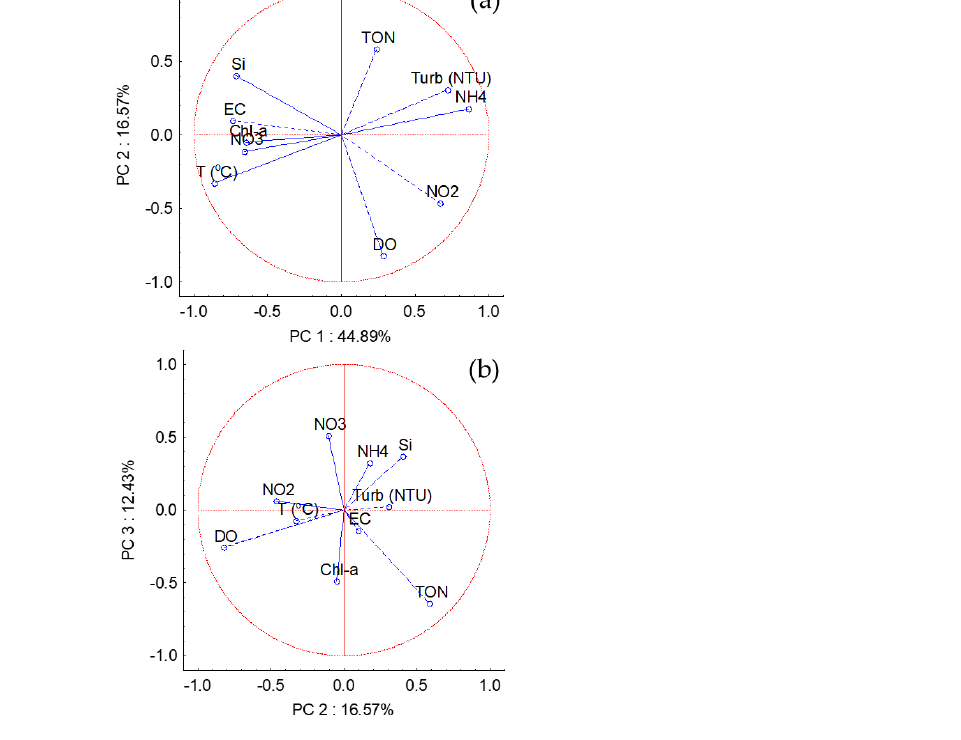
Figure 13. PCA analysis of Lake Paranoá reservoir water quality parameter. ( a ) PC1 × PC2 and ( b ) PC2 × PC3.